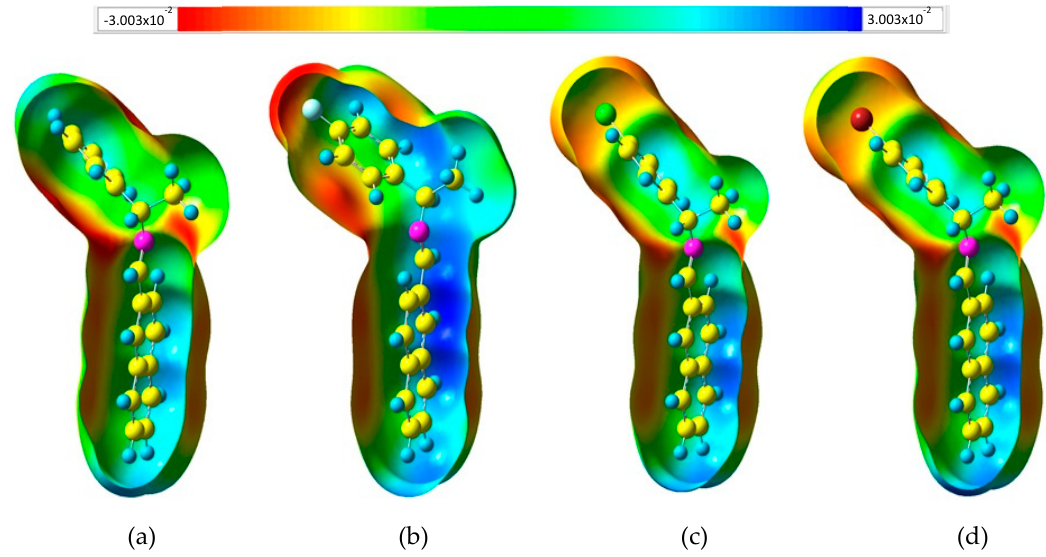
Figure 3. Isosurface of the total electron density mapped with molecular electrostatic potential (isovalue 0.07 a.u.) of ( a ) I , ( b ) I − F , ( c ) I − Cl , and ( d ) I − Br